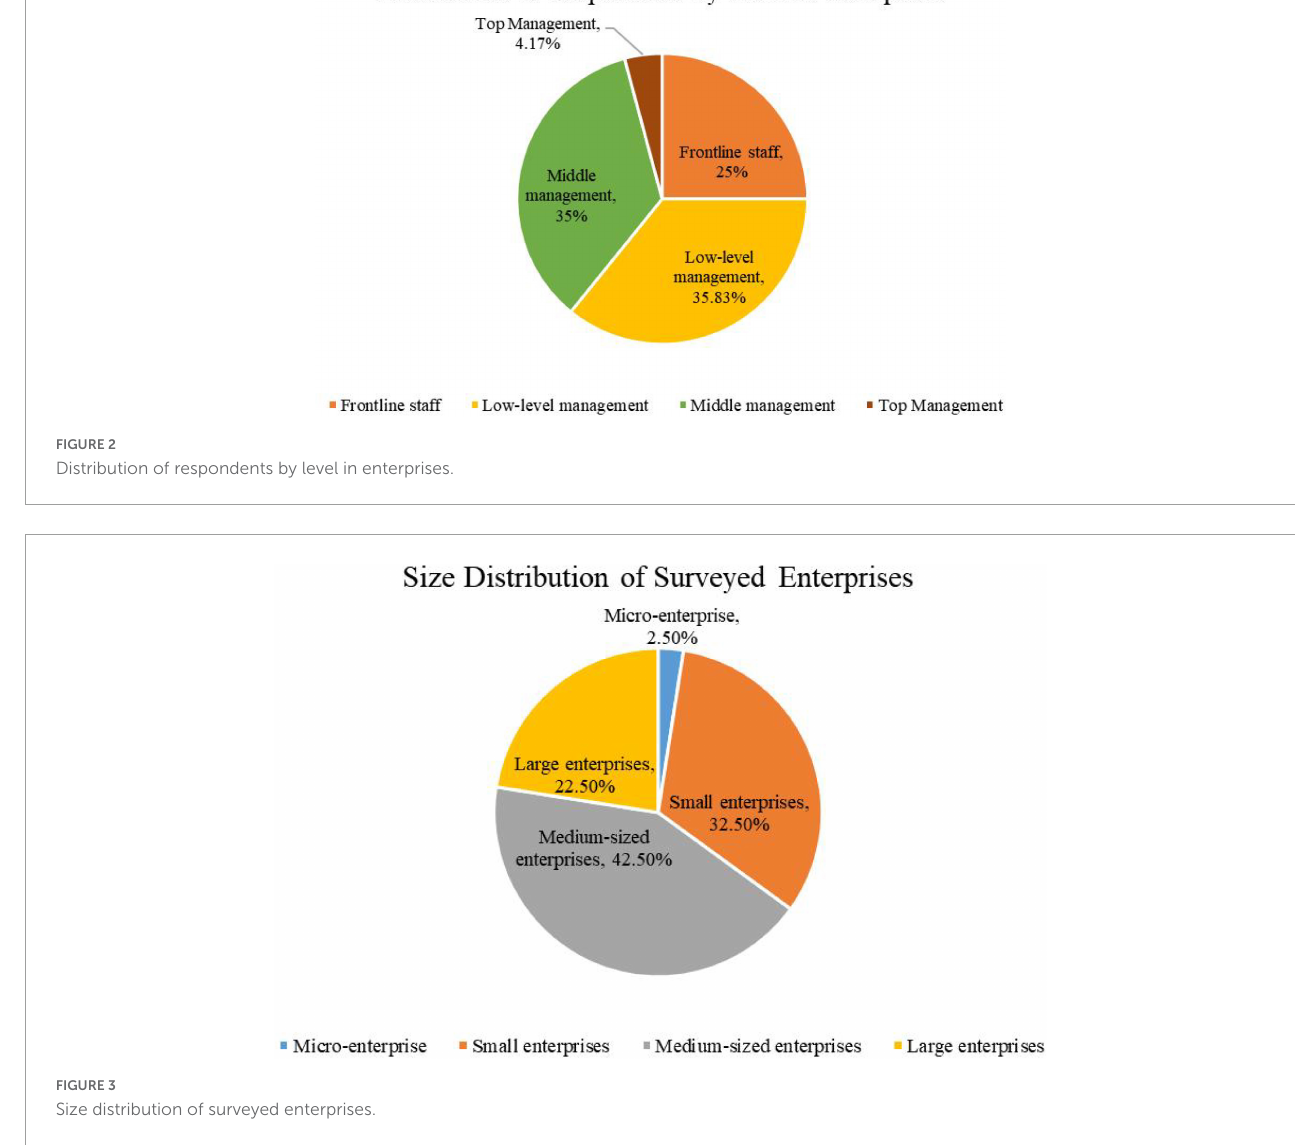
FIGURE3 Size distribution of surveyed